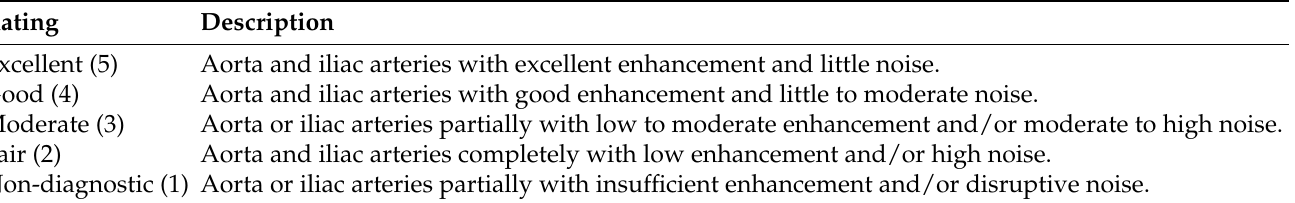
Table 1. Evaluation criteria for subjective image